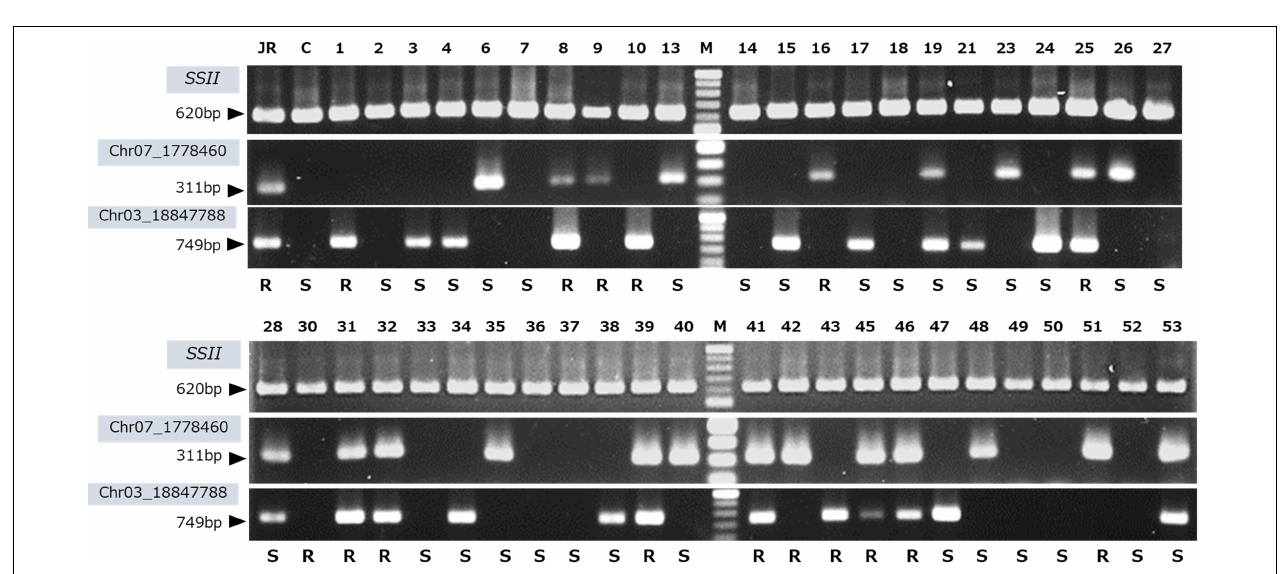
FIGURE 5 | Frequency distribution of the mean number of egg masses on F 1 lines grouped by genotype, based on the Chr07_1778460 (Aaaaaa or aaaaaa) and Chr03_18847788 (Bbbbbb or bbbbbb) SNPs. The F1 mapping population was divided into four groups: Aaaaaa × Bbbbbb, Aaaaaa × bbbbbb, aaaaaa × Bbbbbb, and aaaaaa × bbbbbb.